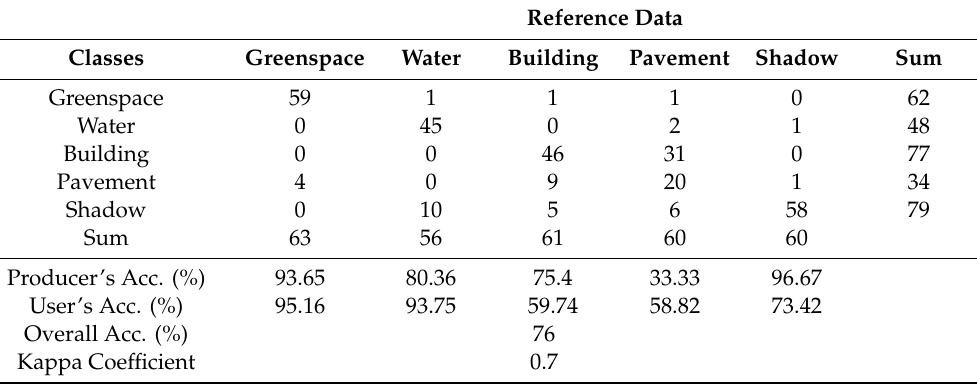
Table 5. The classification accuracies in Method 2.